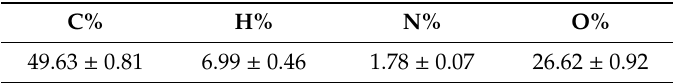
Table 2. Ultimate analysis (daf) of the FW investigated